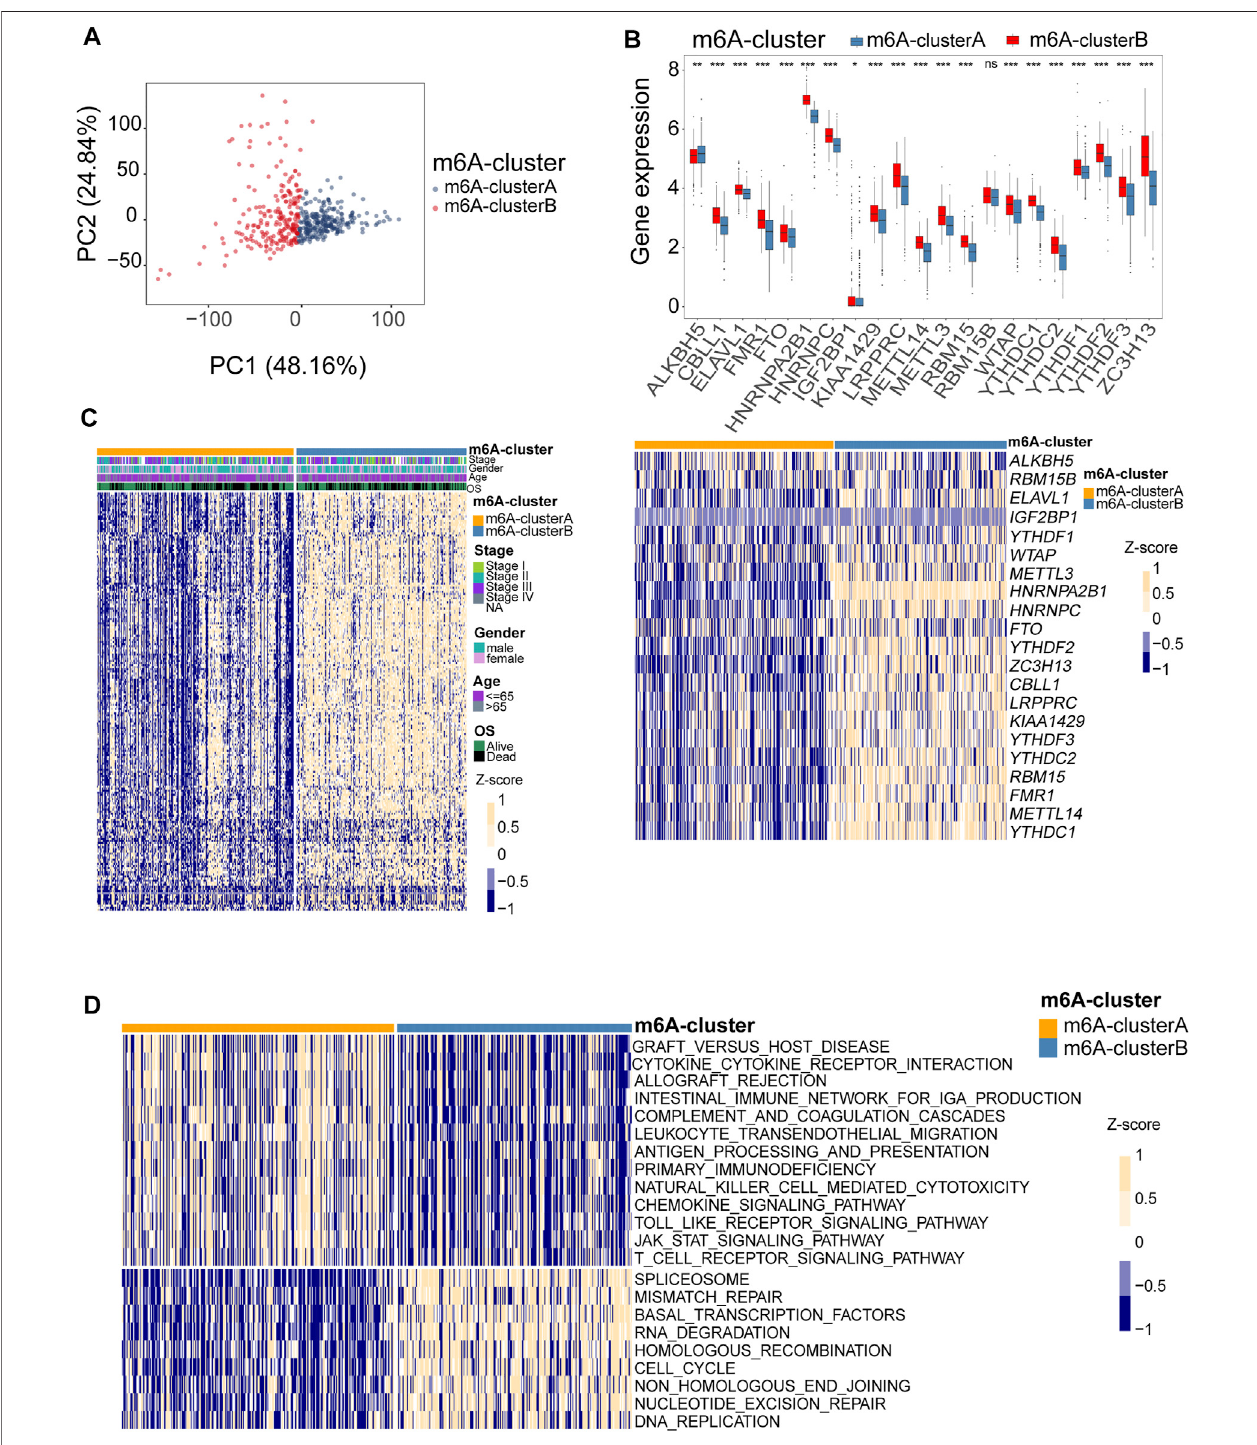
FIGURE 4 | Identi fi cation of consensus clusters by 21 m6A regulators. (A) Principal component analysis indicated that there was a signi fi cant difference in transcriptomebetweenthetwom6Aclusters. (B) Boxplotswereusedtovisualizethedifferentialexpressionof21m6Aregulatorsintwoclusters(upper,* p < 0.05,** p < 0.01, *** p < 0.001).TheheatmapshowstheZ-score-transformedexpression levels of21m6Aregulatorsbetweenthetwom6Aclusters (down) . (C) clinicopathological manifestations between the two m6A-clusters. (D) The heatmap shows the activation states of pathways between the two m6A clusters, and yellow represents activated and blue represents repressive pathways.